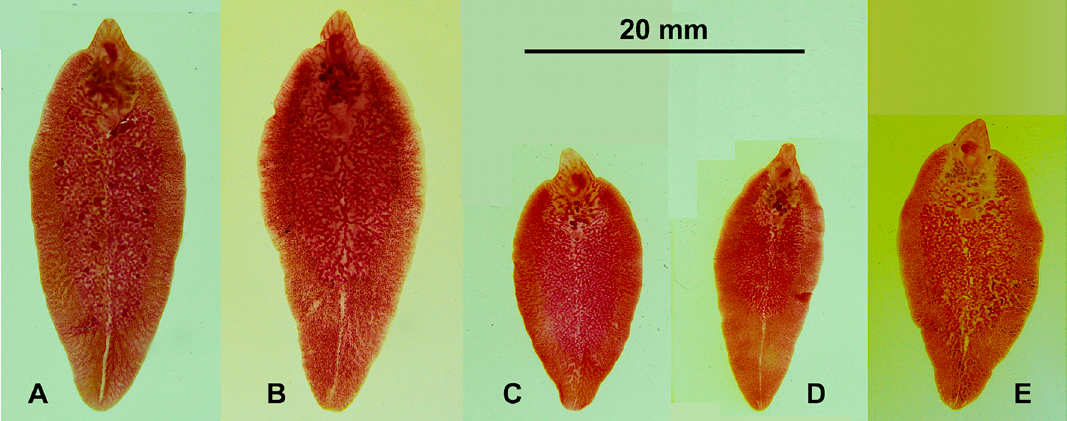
Figure 3. Standard liver fluke specimens of the populations infecting sheep in South America: ( A , B ) San Juan de Chillogallo, Ecuador (nEc); ( C ) Cajamarca, Peru (nCaj); ( D ) Mantaro valley, Peru (nMan); ( E ) Northern Altiplano, Bolivia (nAlt). All specimens shown at the same scale. Table 2. Comparative morphometric data (extreme values, mean and standard deviation) of natural and experimental liver flukes of Fasciola hepatica from lowland sheep ( n = number of individuals). Adult Measurements